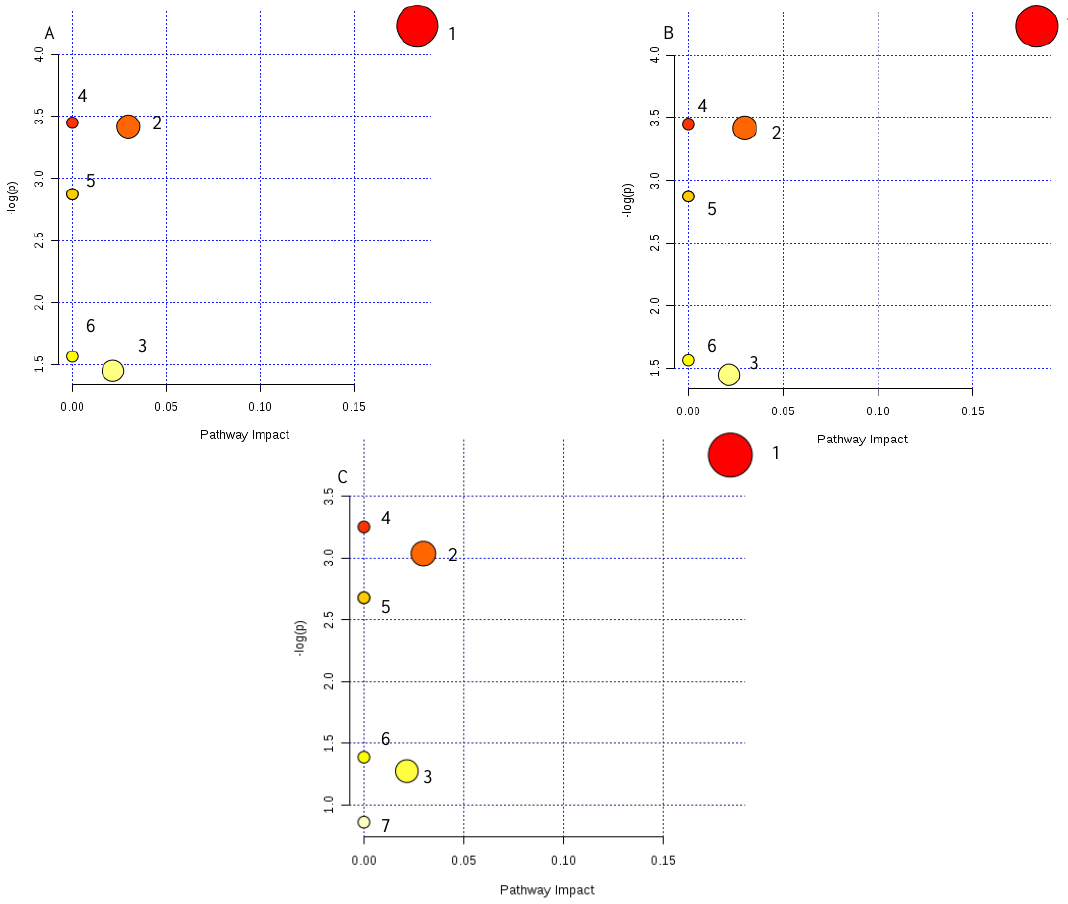
Figure 9. Metabolic pathways involved in potential markers in plasma and urine. ( A ) Scutellaria Radix group (SR); ( B ) Coptidis Rhizome group (CR); ( C ) metformin group (P), Low dose of combined extracts group (LSC) and High dose of combined extracts group (HSC). ( 1 ) Glycerophospholipid metabolism, ( 2 ) primary bile acid biosynthesis, ( 3 ) pyrimidine metabolism, ( 4 ) linolenic acid metabolism, ( 5 ) alpha-linolenic acid metabolism, ( 6 ) arachidonic acid metabolism, ( 7 ) purine metabolism.